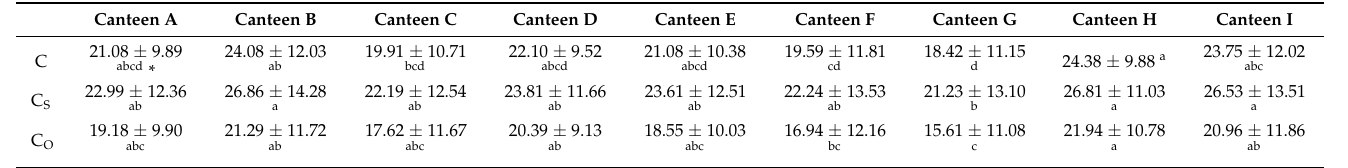
Table 5. Oil–Salt Visual Analogue Scale (OS-VAS) results of nine canteens.